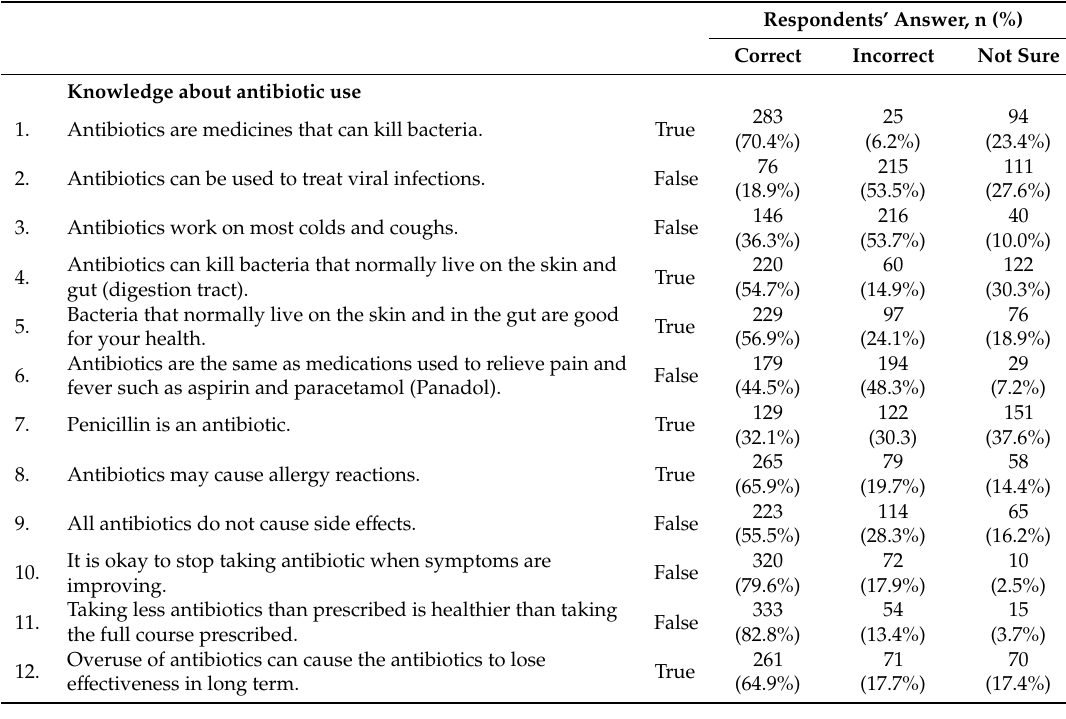
Table 3. Knowledge about antibiotic use and resistance (n =